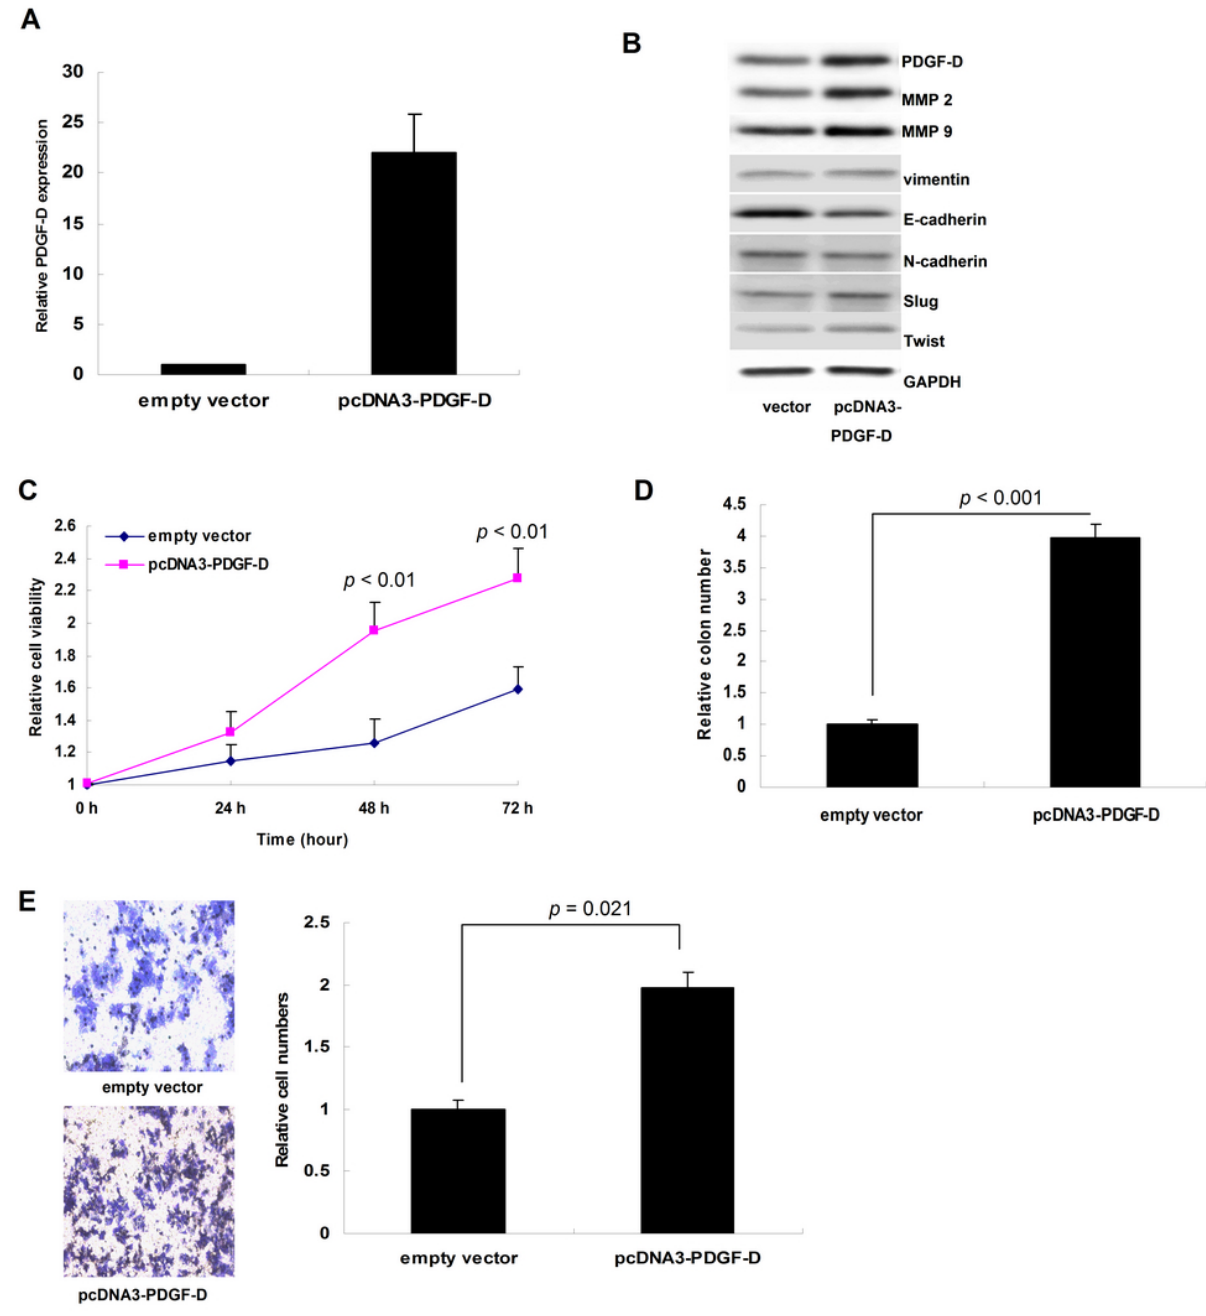
Figure 3. In ECC-1 cells, up-regulation of PDGF-D accelerated cell proliferation and invasion through increasing matrix metalloproteinase (MMP)2, MMP9 and promoting epithelial-mesenchymal-transition (EMT). ( A ) PDGF-D mRNA was up-regulated after transfection with pcDNA3-PDGF-D; ( B ) PDGF-D protein was up-regulated after transfection, and MMP2, MMP9, vimentin, Slug and Twist were increased, while E-cadherin was decreased; ( C ) PDGF-D over-expression promoted cellular growth in MTT assay ( p = 0.028); ( D ) PDGF-D over-expression enhanced the colony formation ( p = 0.012); ( E ) PDGF-D also notably enhanced the cellular invasion in Transwell assay ( p <